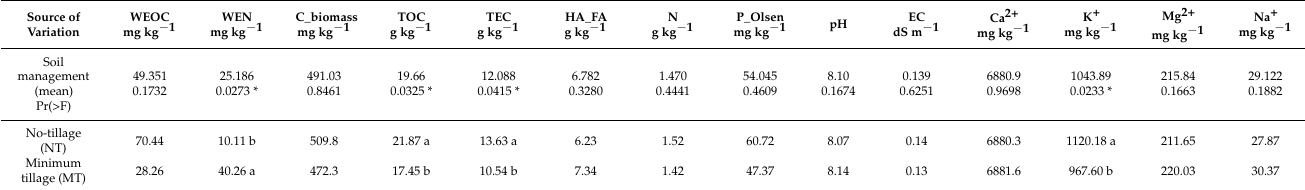
Table 1. Results of nested analysis of variance carried out on soil chemical and biological